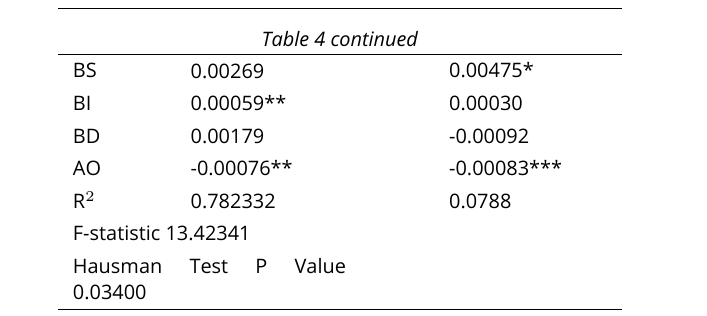
Table 5 indicates the results of fixed-effect regression of FS and Tobin’s Q. Results indicate that FS positively and significantly influences the firm’s